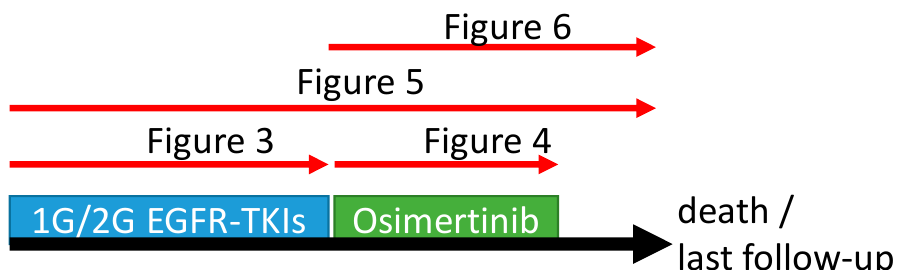
Figure 2. Event-free survival evaluated in the current